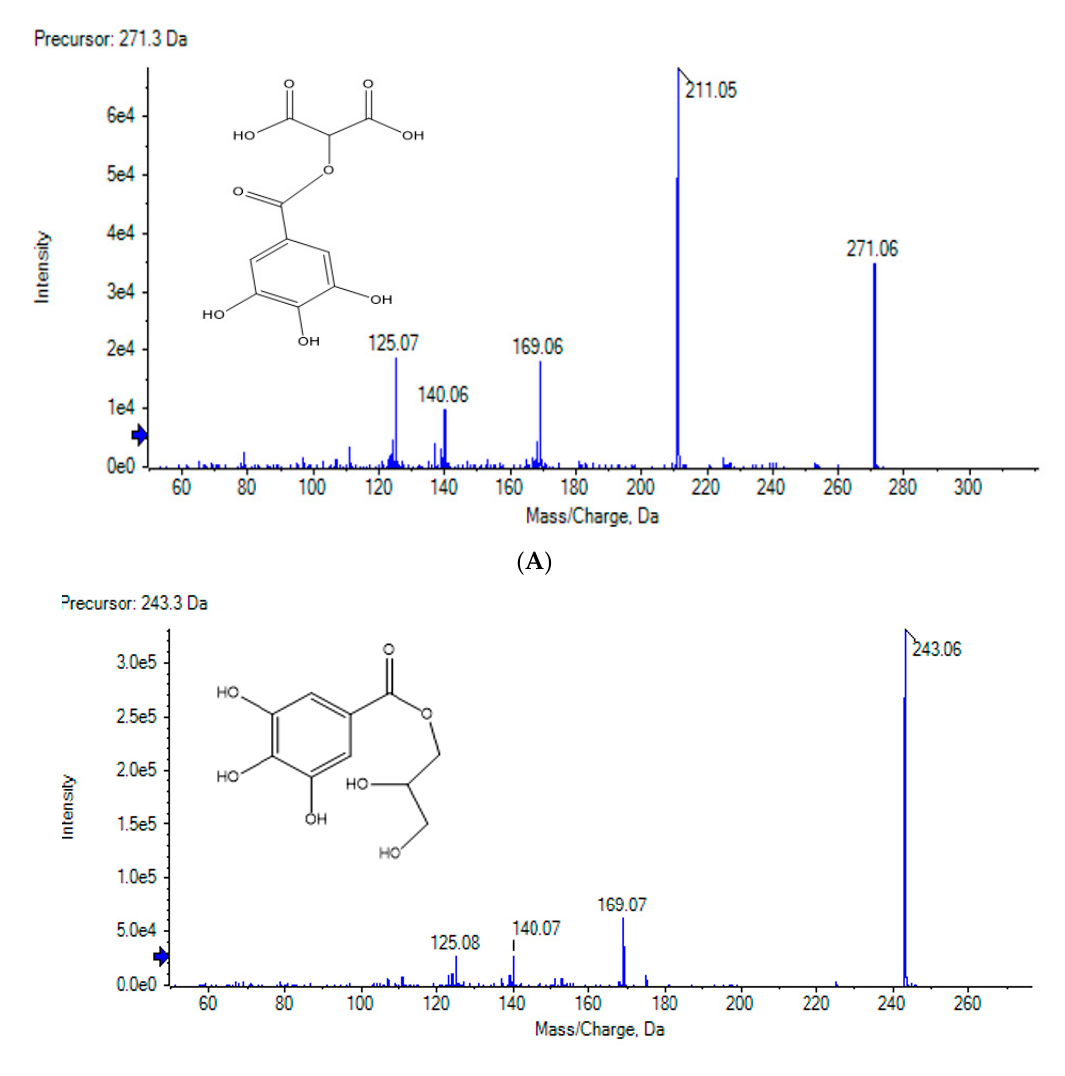
Figure 2. ( A ) LC-MS/MS of Compound 2 ( 2- O -galloyl hydroxy malonic acid); ( B ) LC-MS/MS of Compound 6 (Gallic acid glyceride).